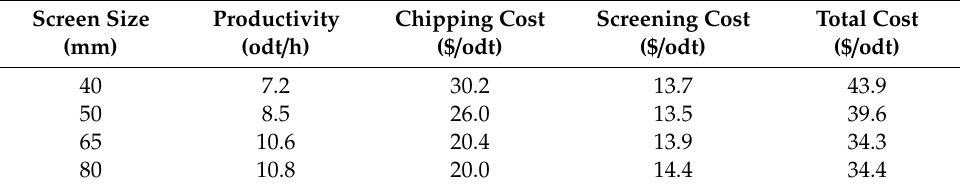
Table 7. Analysis of the productivity and cost of the chipping and screening operation considering fines particles by screen size (fine content was less than 5